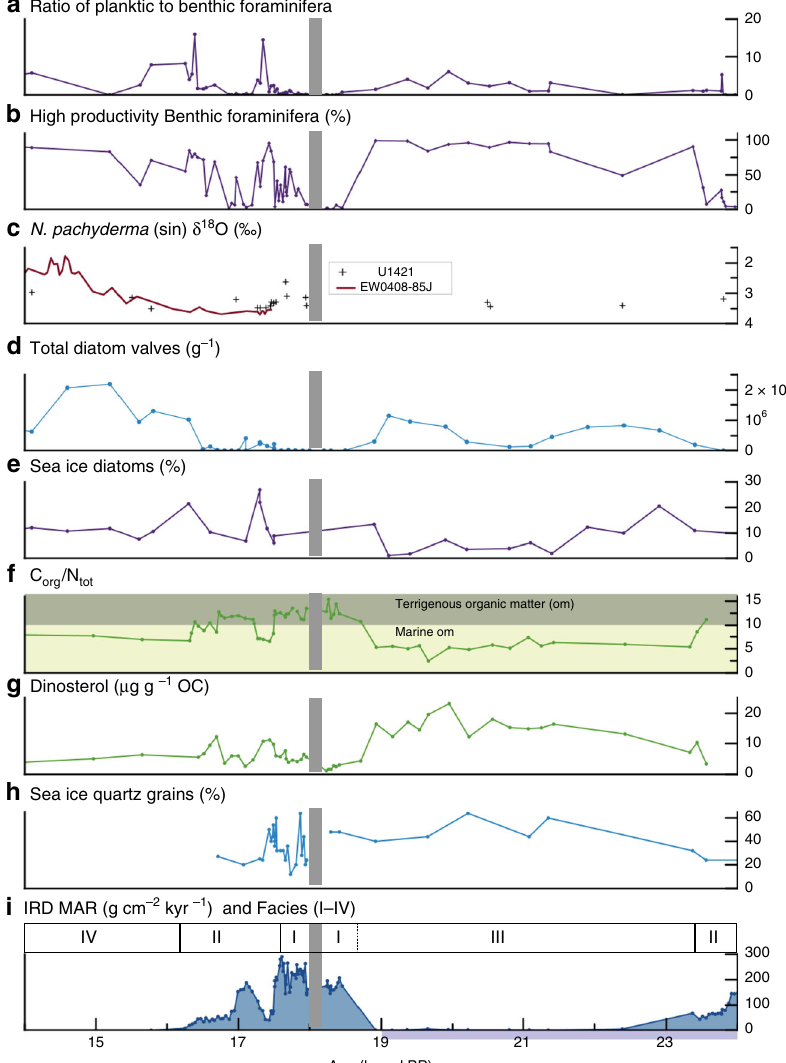
Fig. 5 Multiproxy records from slope Site U1421 for 24 to 14 kyr ago. Biotic and biogeochemical conditions at the end of the LGM and during the terminal BIS retreat are shown. Sedimentary records show a sea-ice-dominated glacier margin just prior to terminal retreat. High productivity and a marine source of organic matter occur during periods of low IRD MAR. Quartz microtextures and sea-ice diatoms indicate sea-ice over shelf, reducing IRD MAR at site U1421. a Planktic to benthic foraminifera ratio. b Percentage of benthic taxa indicative of high productivity and reduced oxygen conditions. c Values for δ 18 O analysis of N. pachyderma (sin.) in samples from site U1421 and survey site EW0408-85JC 27 . Error bars (±1 sigma) are smaller than symbol size. d Total diatom valves per gram of sediment. e Percentage of sea-ice diatoms. f Ratio of organic carbon to total nitrogen. The boundary between marine and terrestrially sourced is drawn at a value of 10 39,40 . g Dinosterol ( μ gg − 1 organic carbon (OC)). h Percent quartz grains with sea-ice microtextures. i IRD MAR and lithofacies. LGM from 26.5 to 19 ka cal BP 14 is shown by purple bar. Gray shaded area is an interval of no core